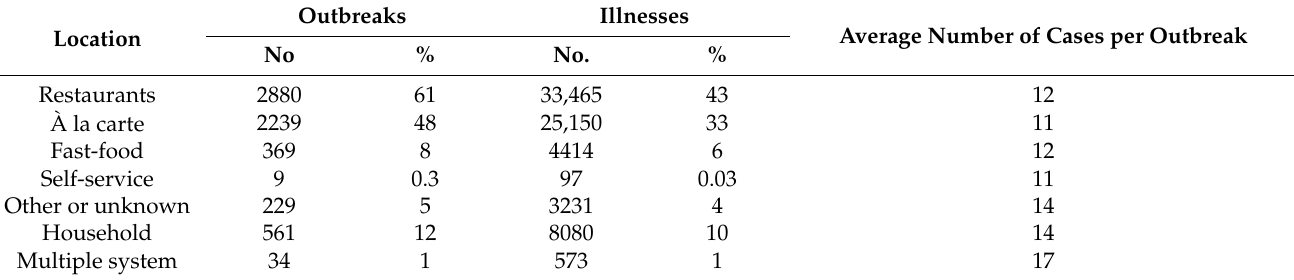
Table 1. Outbreaks of FBD by location of food preparation in the US and Puerto Rico, between 2009 and 2015.